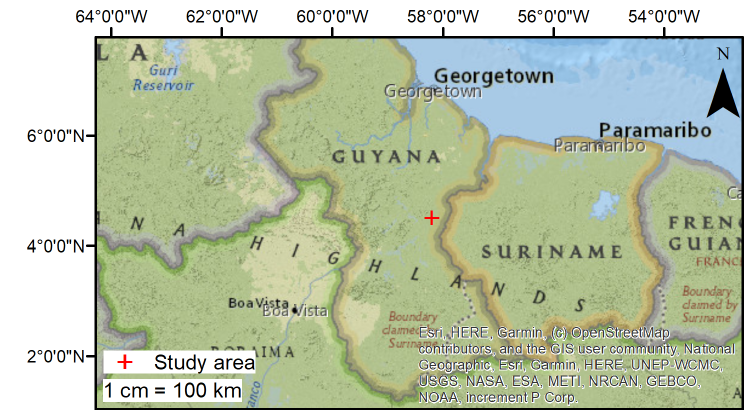
Figure 1. Map of the study area in Guyana